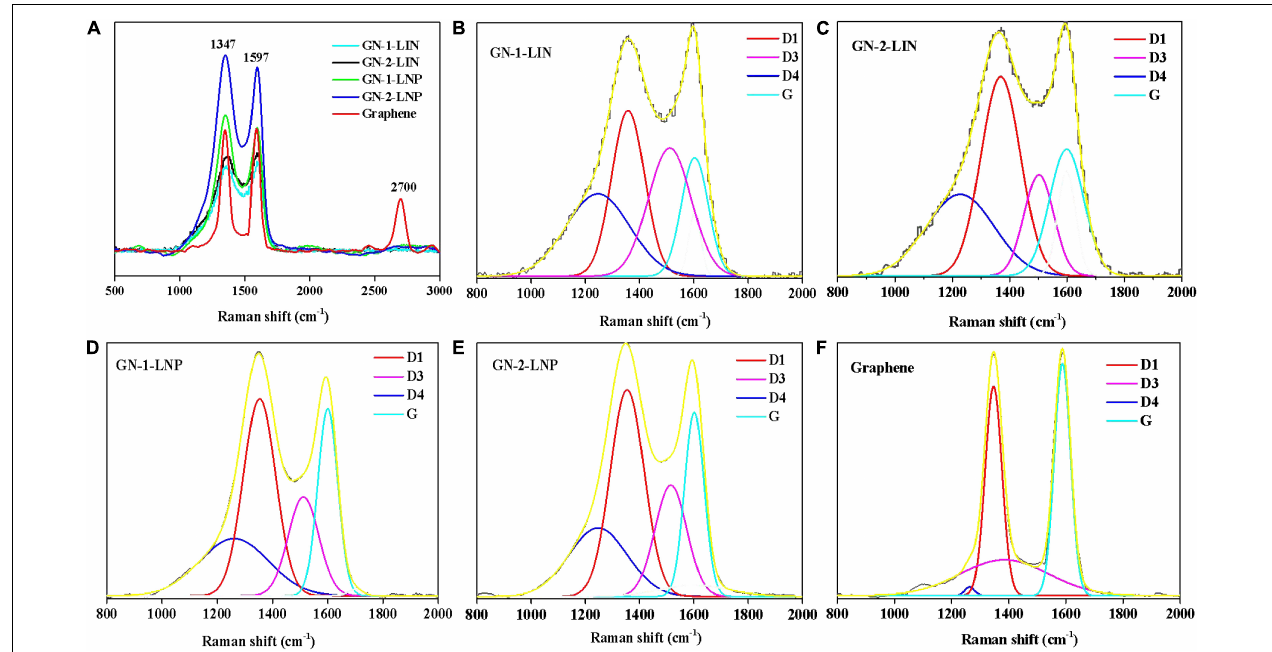
FIGURE 5 | Raman spectra of the prepared carbons and commercial graphene (A) , deconvoluted Raman spectra of GN-1-LIN (B) , GN-2-LIN (C) , GN-1-LNP (D) , GN-2-LNP (E) , and commercial graphene (F) .